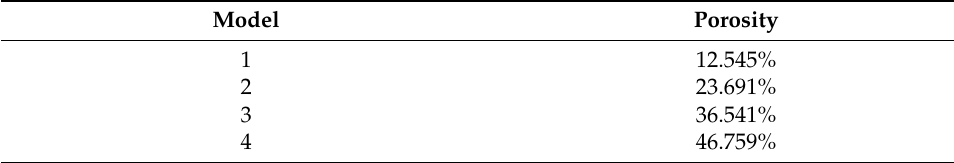
Table 4. Parameters of the calculation model.